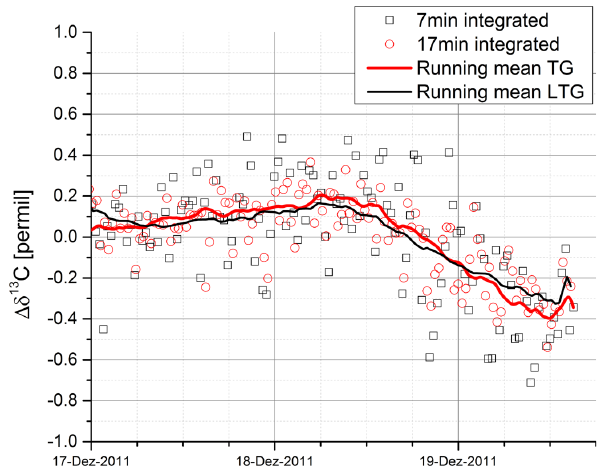
Fig. 3. Instrumental drift of the Picarro δ 13 C raw monitored over 2 days using two gas cylinders TG48-A (black) and LTG48-A (red) measured twice per hour. To highlight the trend a running mean (6h window) is given in the solid